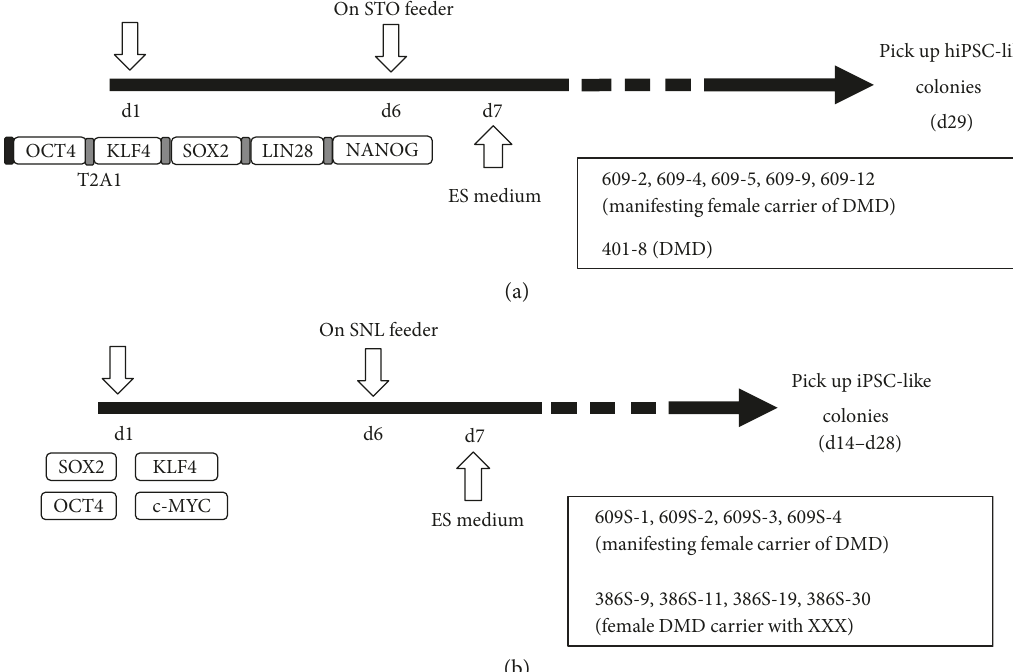
Figure 1: Time schedules of hiPS induction using an all-in-one retroviral vector (a) or four Sendai viral vectors (b). Fibroblasts from a manifesting female carrier of DMD (609) were infected with a retroviral vector, encoding fi ve reprogramming factors. After replating onto MMC-treated STO feeder cells, colonies were picked up (a). Next, fi broblasts of 609 and a female DMD patient (386) were infected with four Sendai viral vectors on SNL feeders, and ES-like colonies were picked up 14 – 21 days after transduction